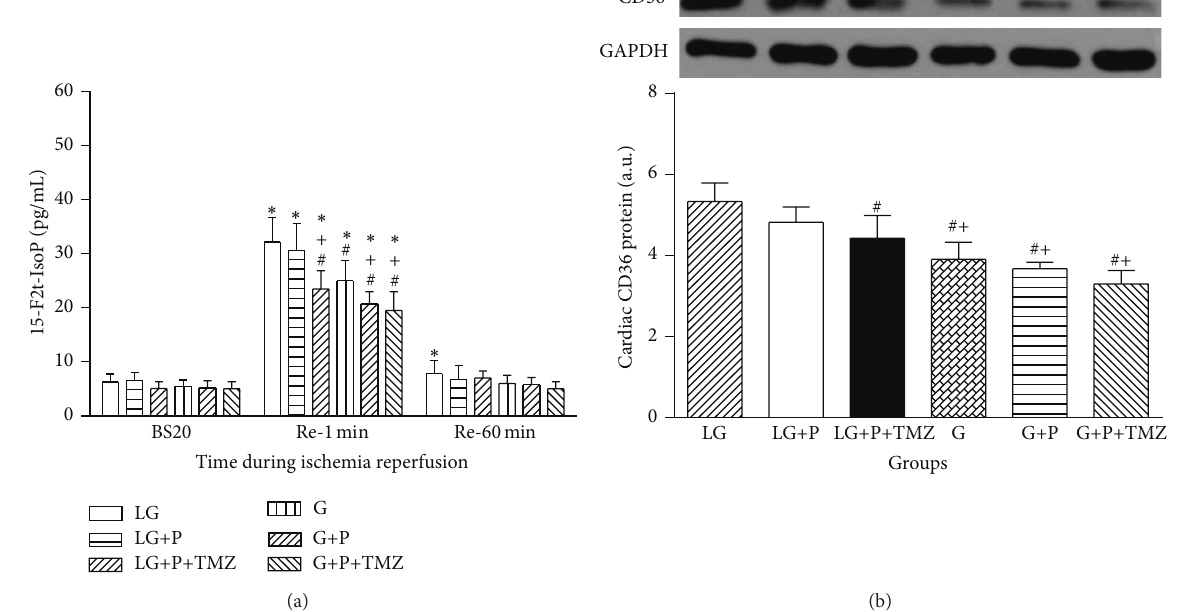
Figure 4: Effect of low glucose (LG) and glucose (G) on cardiac 15-F2t-isoprostane (15-F2t-IsoP) and cardiac CD36 protein expression. Cardiac 15-F2t-IsoP, a specific index of ROS-induced oxidative stress, was higher in LG that was associated with higher cardiac lipid transporter CD36 protein expression than in G. Propofol significantly reduced 15-F2t-IsoP as well as CD36 in G but not in LG. TMZ did not change the protein level of CD36 in LG. BS20 is abbreviation of 20min after stabilization. Values are presented as mean ± SEM. 𝑁 = 7 per group. ∗ 𝑃 < 0.05 versus BS20; # 𝑃 < 0.05 versus LG; + 𝑃 < 0.05 versus LG+P.